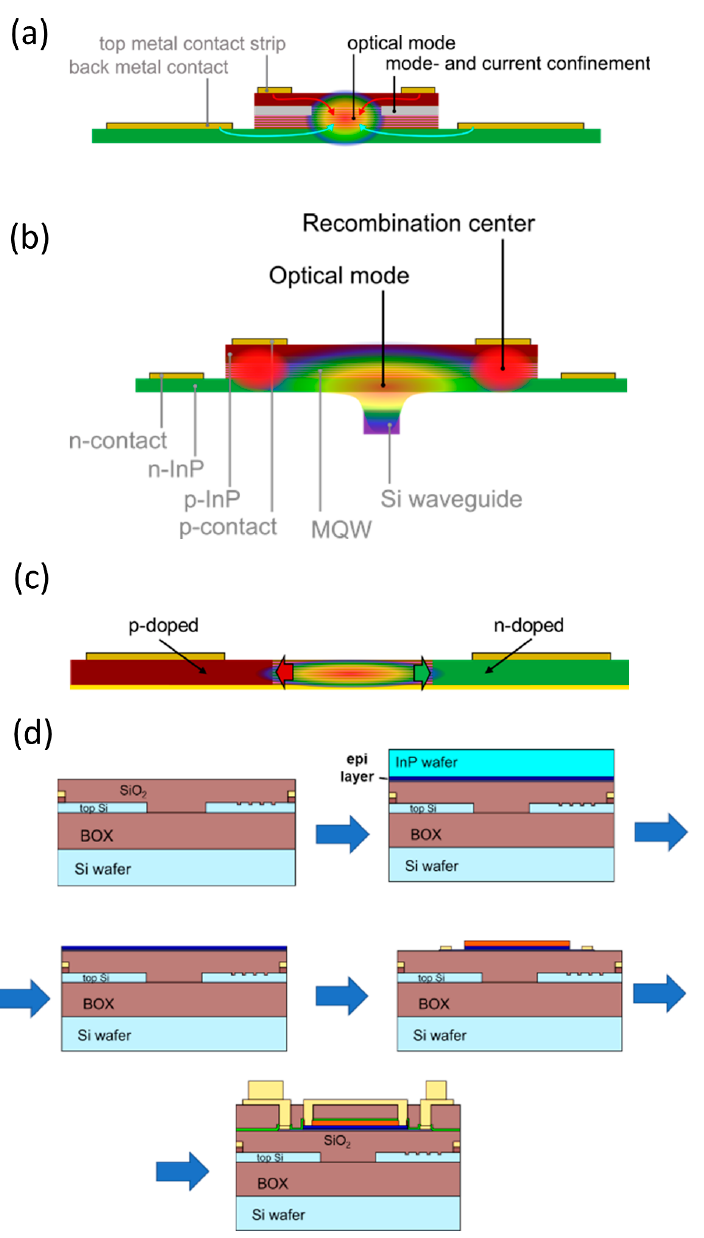
Figure 13. ( a ) The vertical current injection scheme for thin III–V layers integrated on silicon. ( b ) The vertical scheme leads to some recombination of the carriers at the edges of the mesa and insufficient overlap with the optical mode. ( c ) Lateral current injection scheme. In ( d ), we show the high-level process flow for realizing the III–V on silicon lasers. The silicon chip with the passive photonic structures is planarized by chemical mechanical polishing. Then, the InP wafer with the gain quantum-well stack is bonded to the silicon wafer. The InP wafer is removed, the III–V gain sections are etched, and finally, the electrical contacts are applied.